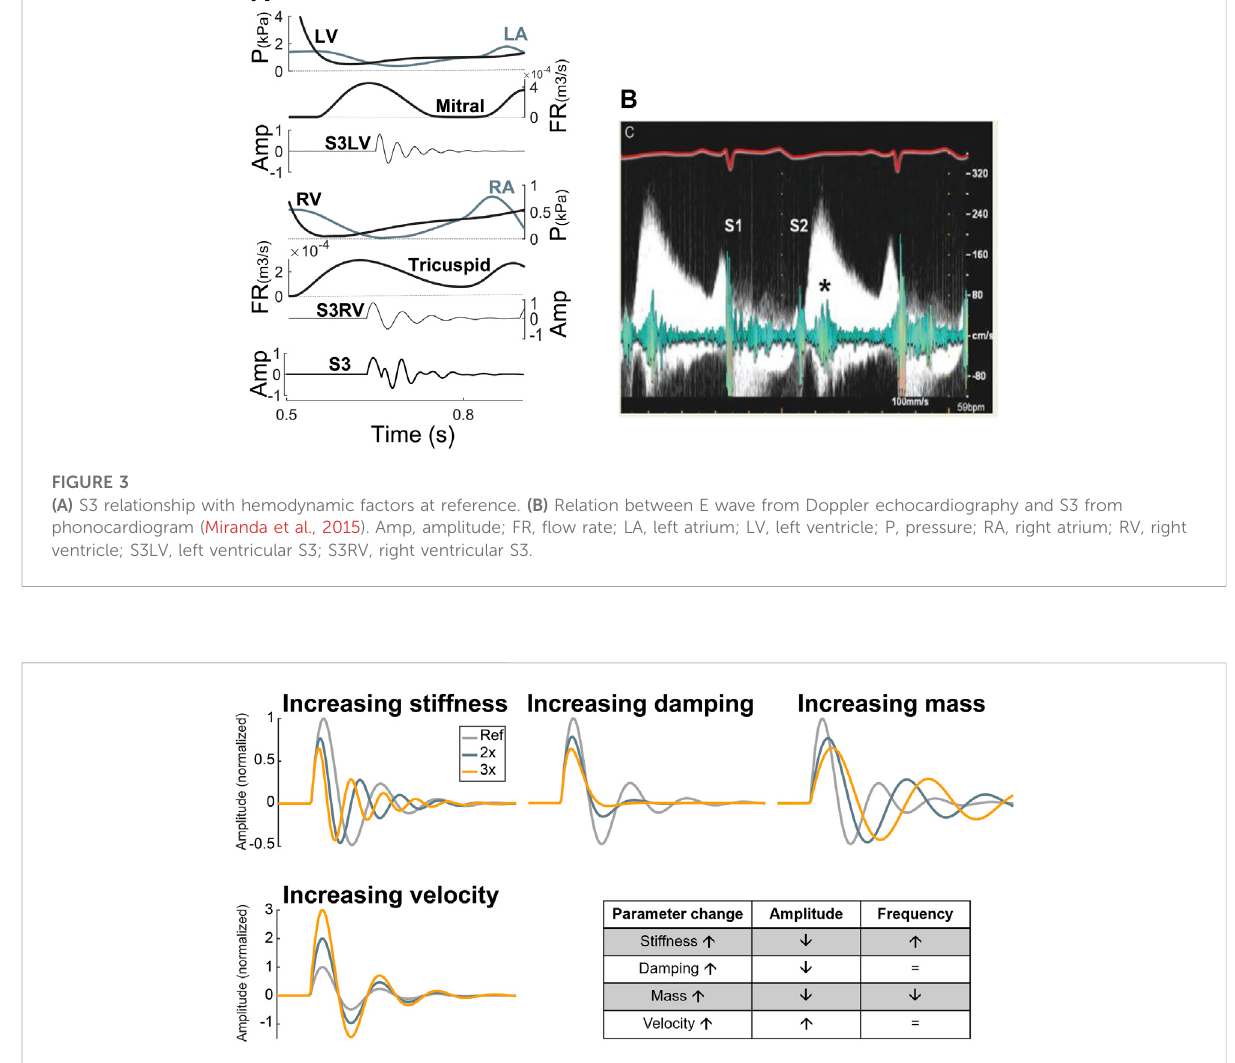
FIGURE 4 Parameter analysis of the S3 model. Ref: reference, 2x: two-fold of reference, 3x: three-fold of